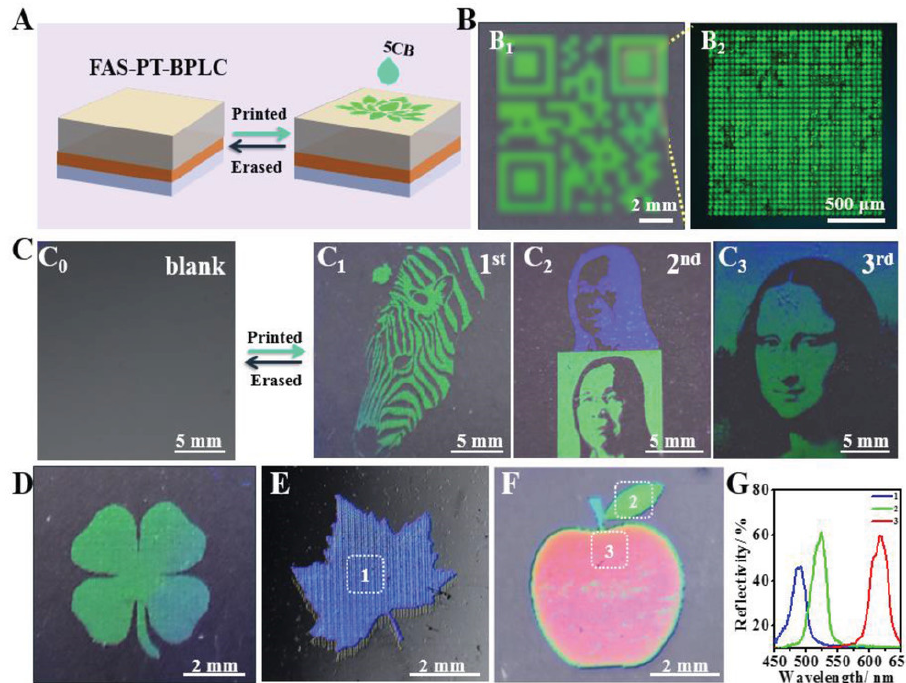
Figure 15. Various erasable patterns on BPLC membrane. ( A ) Scheme for the fabrication process of the erasable image on BPLC. ( B – F ) Photographs of the erasable images of the BPLC membranes. ( B ) Photo and reflective POM image of Quick code. ( C ) Reversible writing/erasing process of (C1) zebra, (C2) a double-color pattern with a portrait was printed using the image and inversed image as the pattern and (C3) Mona Lisa. The pattern was written and erased on the same substrate. Patterns of a ( D ) clover and ( E ) maple leaf, and ( F ) red apple with a green leaf and ( G ) the spectra of the samples with different regions in ( E , F ) [125] . High-Resolution Erasable “Live” Patterns Based on Controllable Ink Diffusion on the 3D Blue-Phase Liquid Crystal Networks from Meng, Advanced Functional Materials, published by John Wiley and Sons.